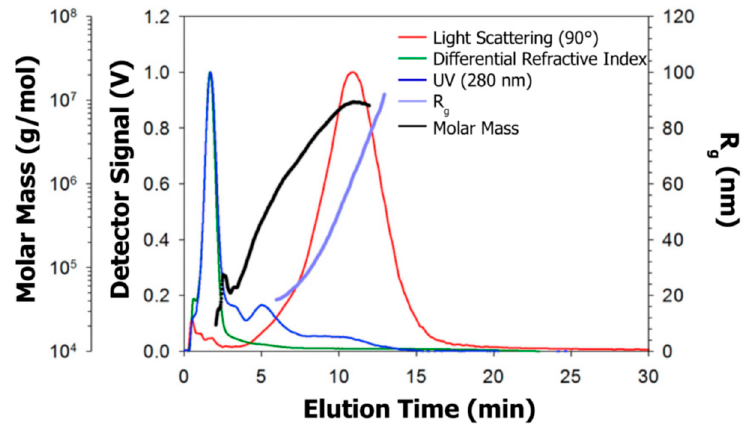
Figure 15. Fractograms of β -casein assemblies obtained by asymmetrical flow field flow fractionation together with the distribution of the molar mass and radius of gyration ( R g ). Reproduced with